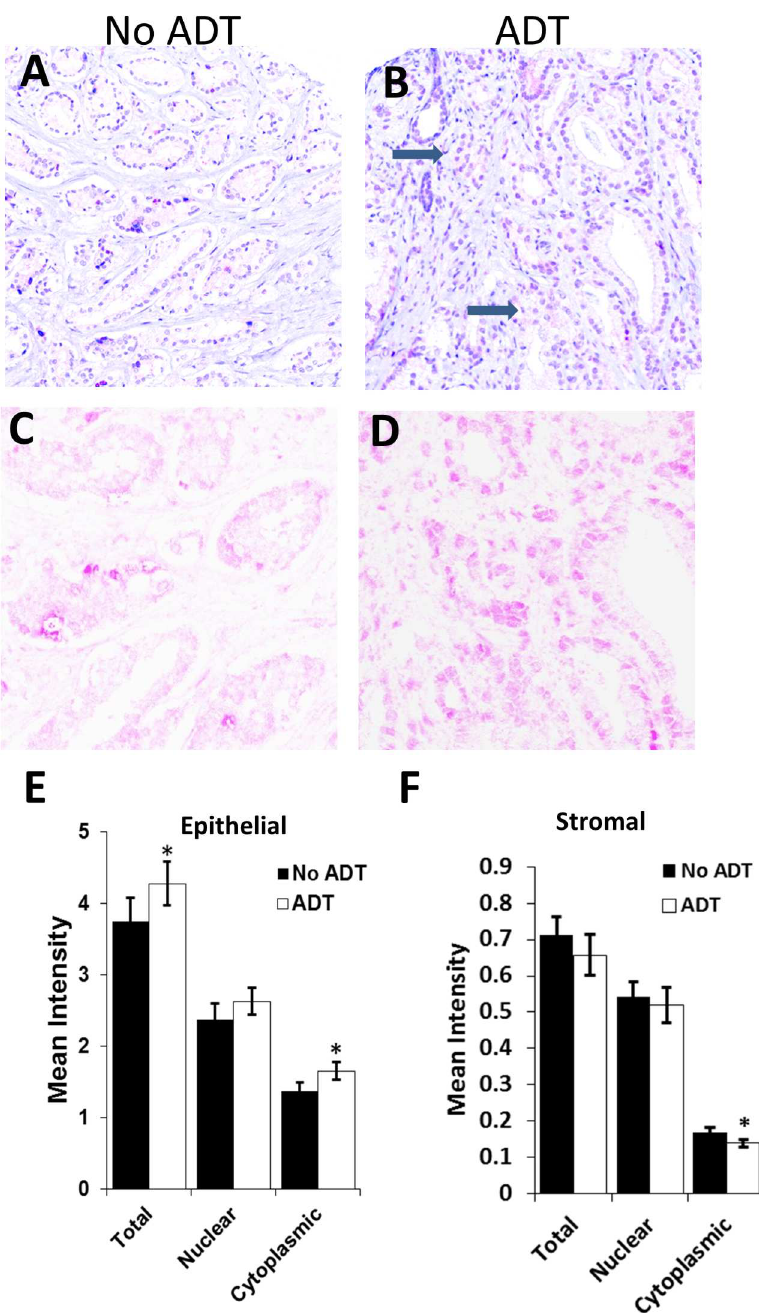
Fig 1. Higher GLB1 levelsafterneoadjuvant ADT in prostatecancertumor tissues. Immunohistochemistry for GLB1 was performedon tissue arraysas described in the methodsandstainingquantitated automatically usingVECTRA.LowerpowerH&E staining(20X)of control(A) andneoadjuvant (B) ADT treatedintermediate gradeprostatecancertissues.Morphologic changesassociatedwith ADT exposure includeshrinkage/loss of acini( ! )makingGleasonscoringinapplicable.Increasedlevelsof GLB1 (purple)are showninnuclearand cytoplasmic compartmentsof ADT treated(D) anduntreated (C) epithelium underhigherpower.(E) Epithelial (tumor)levelsof GLB1 weresignificantlyincreasedin ADT treatedspecimensoverallandin the cytoplasm. (F) No significantincreases in GLB1expressionin stromaltissue treatedwith ADTcomparedto untreatedtissues. * p < 0.05;mean ±